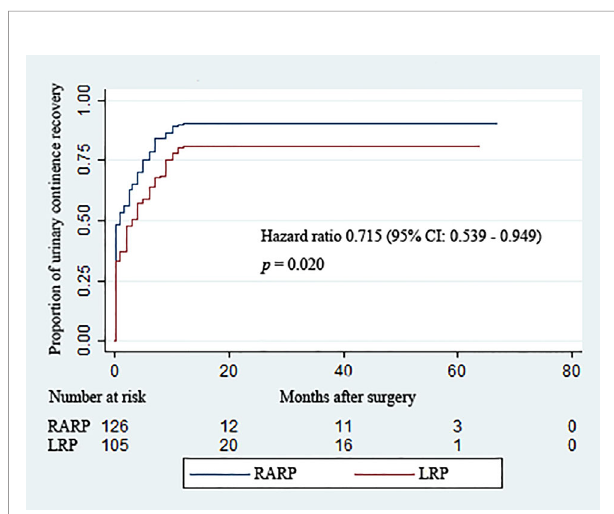
FIGURE 2 | Kaplan – Meier curves showing the proportions of urinary continence (UC) following robot-assisted and laparoscopic radical prostatectomy for prostate cancer with a large prostate volume over the follow-up duration. UC was de fi ned as requiring no pad or preventively using one dry pad per